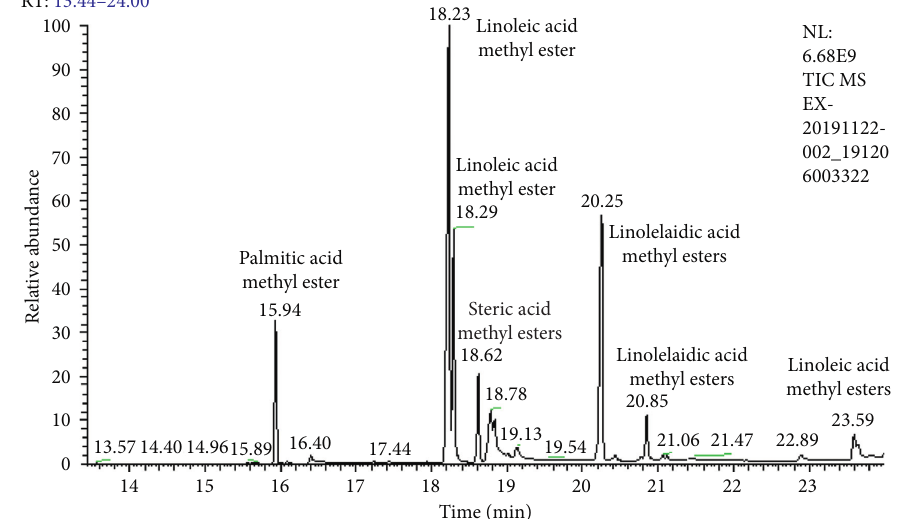
Figure 12: Chromatogram of MMEs catalyzed by CaO-NPs (refer to Supplementary Data Section 2.2).